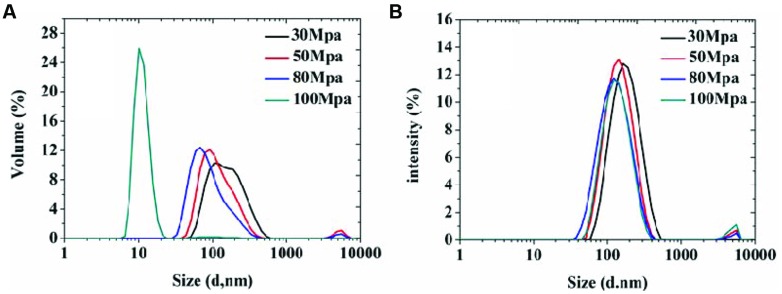
The particle size distributions of organogel-nanoemulsion prepared under different homogenizing pressures were analyzed by DLS [size distributions by volume (A) and intensity (B)].